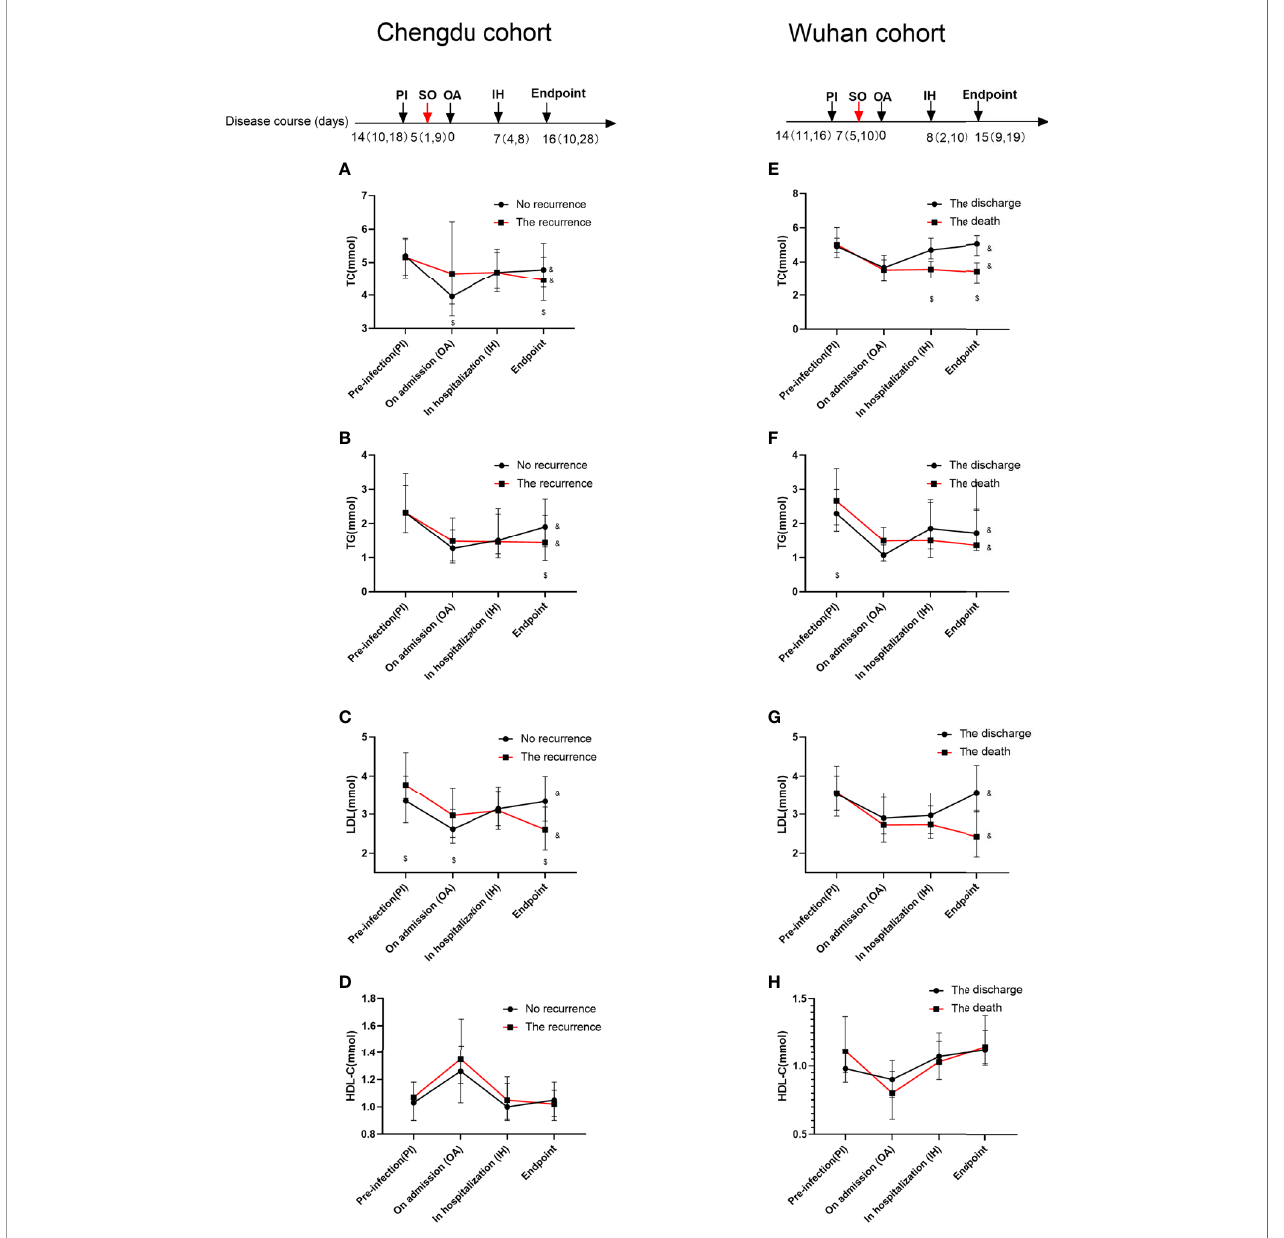
FIGURE 3 | Lipid pro fi les during the disease course for COVID-19 patients in the Chengdu and Wuhan cohorts. The data are presented as median (IQR). The paired non- parametric test is used to compare the difference among different stages in the same cohort subgroup of patients. The Mann – Whitney U test is used to compare the difference between the two groups. $p < 0.05 as compared with the levels between the discharge group and the recurrence or death of patients group in the same stage. &p < 0.05 as compared with the levels in the four stages of the same cohort. The TC, TG, LDL-C, and HDL-C changes during the disease course in the Chengdu cohort are shown in (A – D) . The lipid pro fi le changes during the disease course in the Wuhan cohort are shown in (E – H) . The red arrow indicates the time of symptom onset (SO); the black arrows indicate the four stage times including pre-infection (PI), on admission (OA), in hospitalization (IH), and the time of discharge or in-hospital death